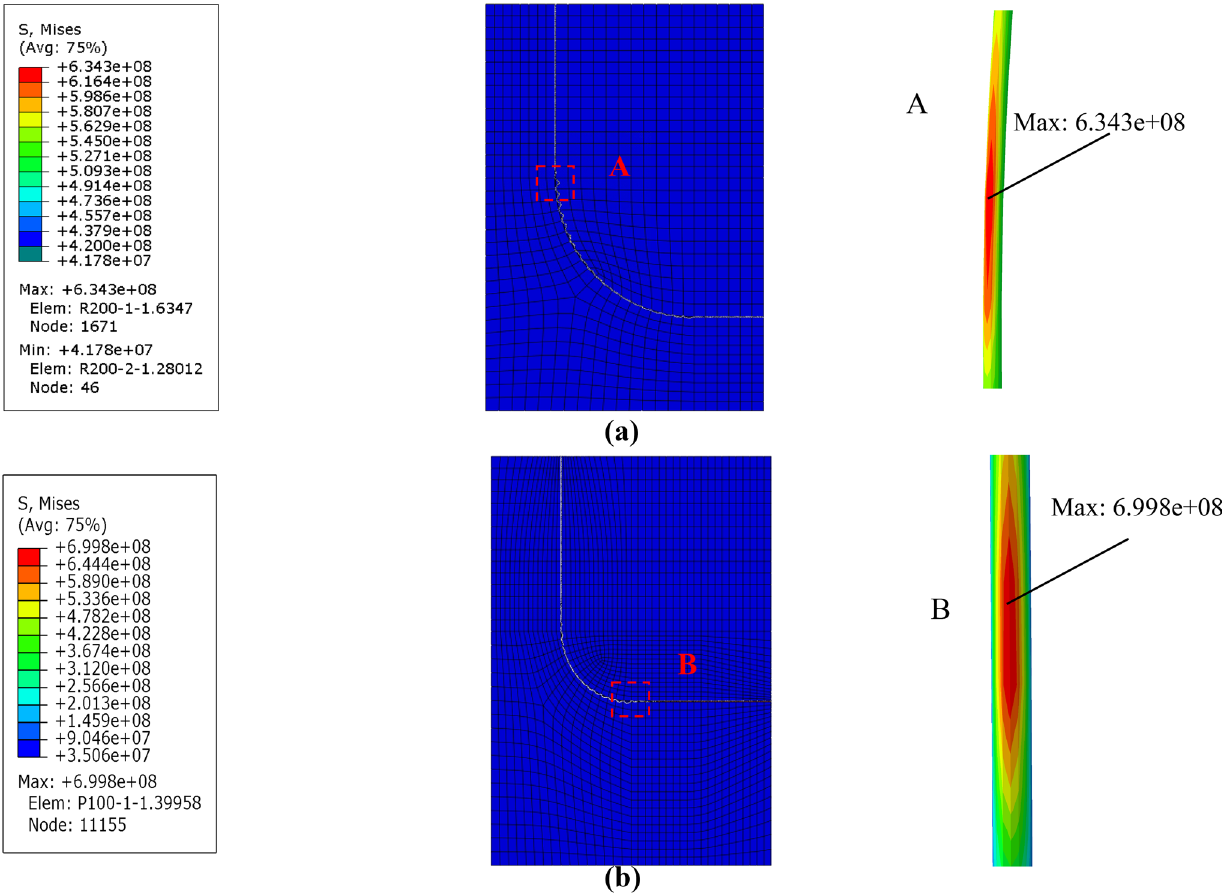
Fig. 4 Cloud map under different borehole curvature. a borehole curvature of 4.3°/30 m. b borehole curvature of 8.59°/30